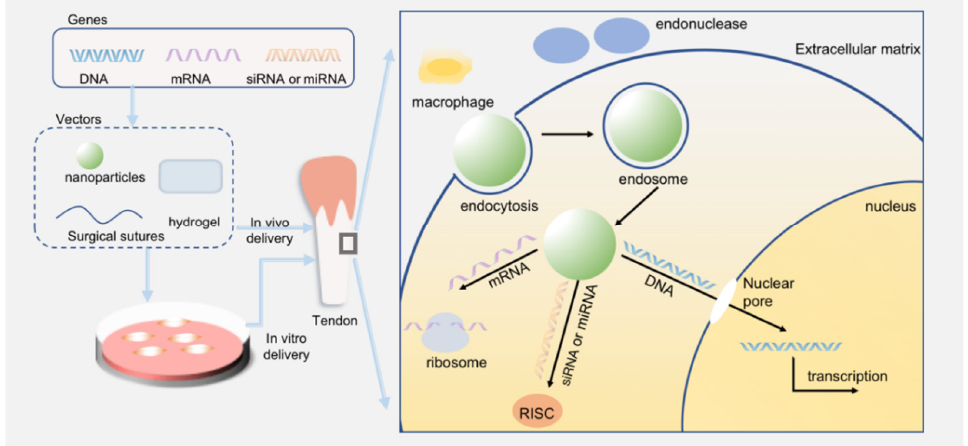
Figure 1. The process of gene therapy and barriers to the successful delivery of nucleic acids. Various genes can be delivered to tendons, including DNA, mRNA, siRNA, and miRNA. These drugs can be transfected with diverse delivery systems, such as nanoparticles, surgical sutures, and hydrogel. Gene therapy consists of two fundamental methods: in vivo and in vitro delivery. When they are released into the extracellular matrix, they have to overcome the degradation of endonucleases and the detection of immune systems. Then, they will be encapsulated in the cell by endocytosis, which induces the production of the endosome. Finally, mRNA will initiate translation; siRNA and miRNA must be loaded into the RNA-induced silencing complex (RISC), while DNA has to pass through the nuclear membrane and function in the nucleus.